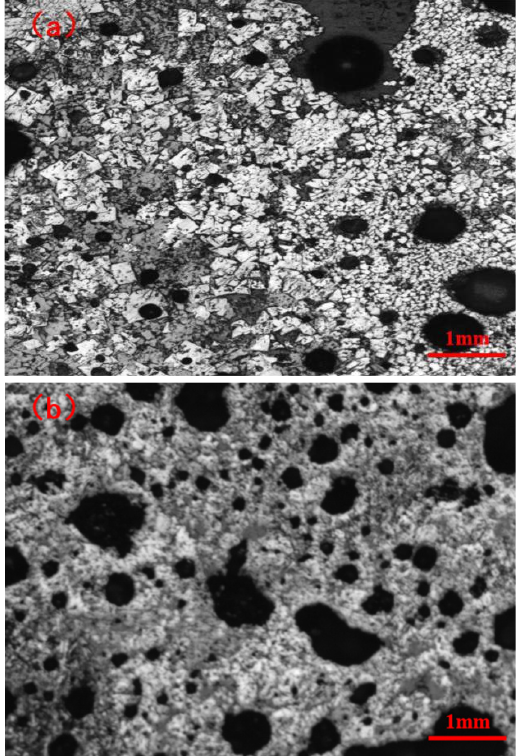
Figure 12. Macrostructure diagrams: ( a ) Thick-walled, small pore structure (Fuel-4.0%), ( b ) Thin- walled, large pore structure (Fuel-6.0%).